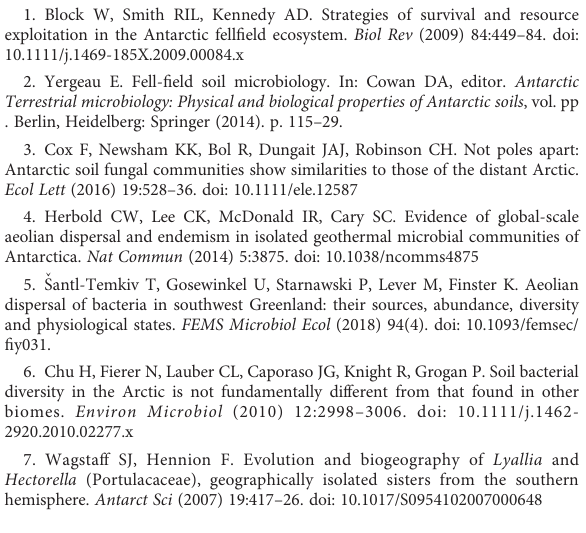
SUPPLEMENTARY TABLE 2 Species richness and Shannon index of the soil microbiomes and of